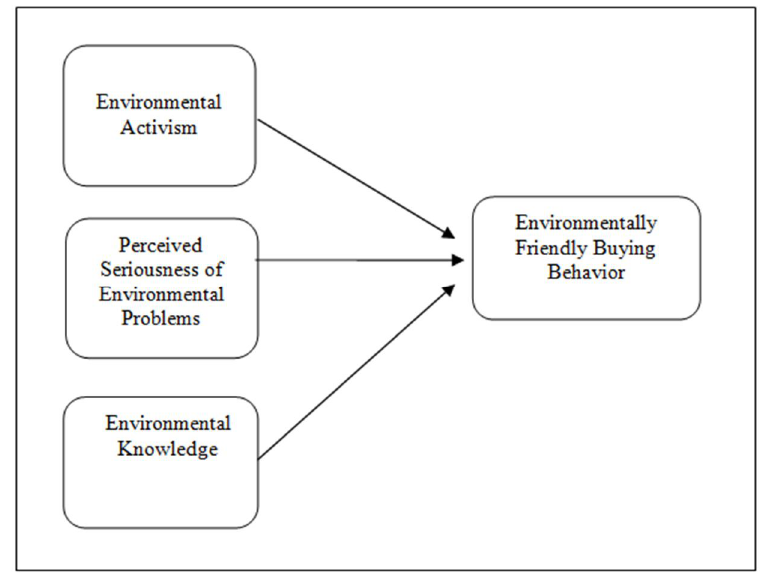
Fig. 1 Model of the proposed relationship between the